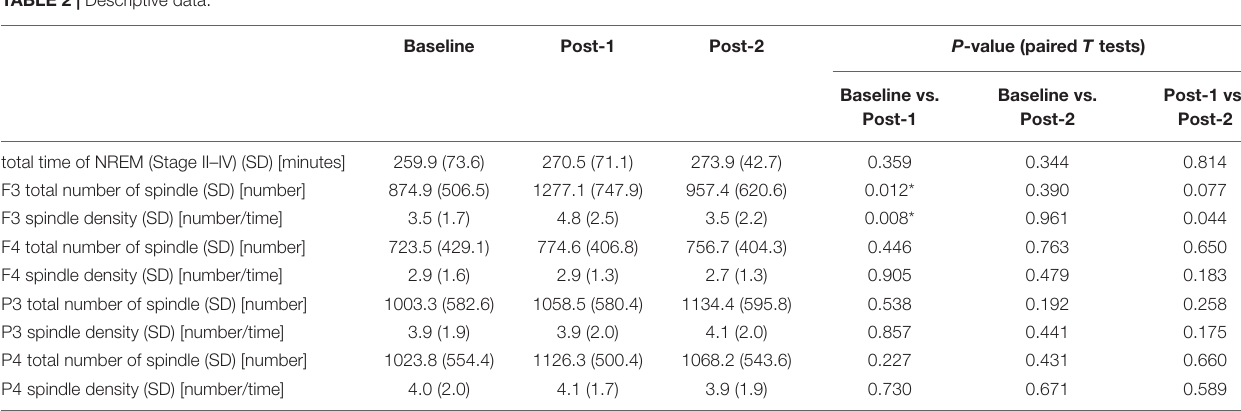
TABLE 2 | Descriptive data.